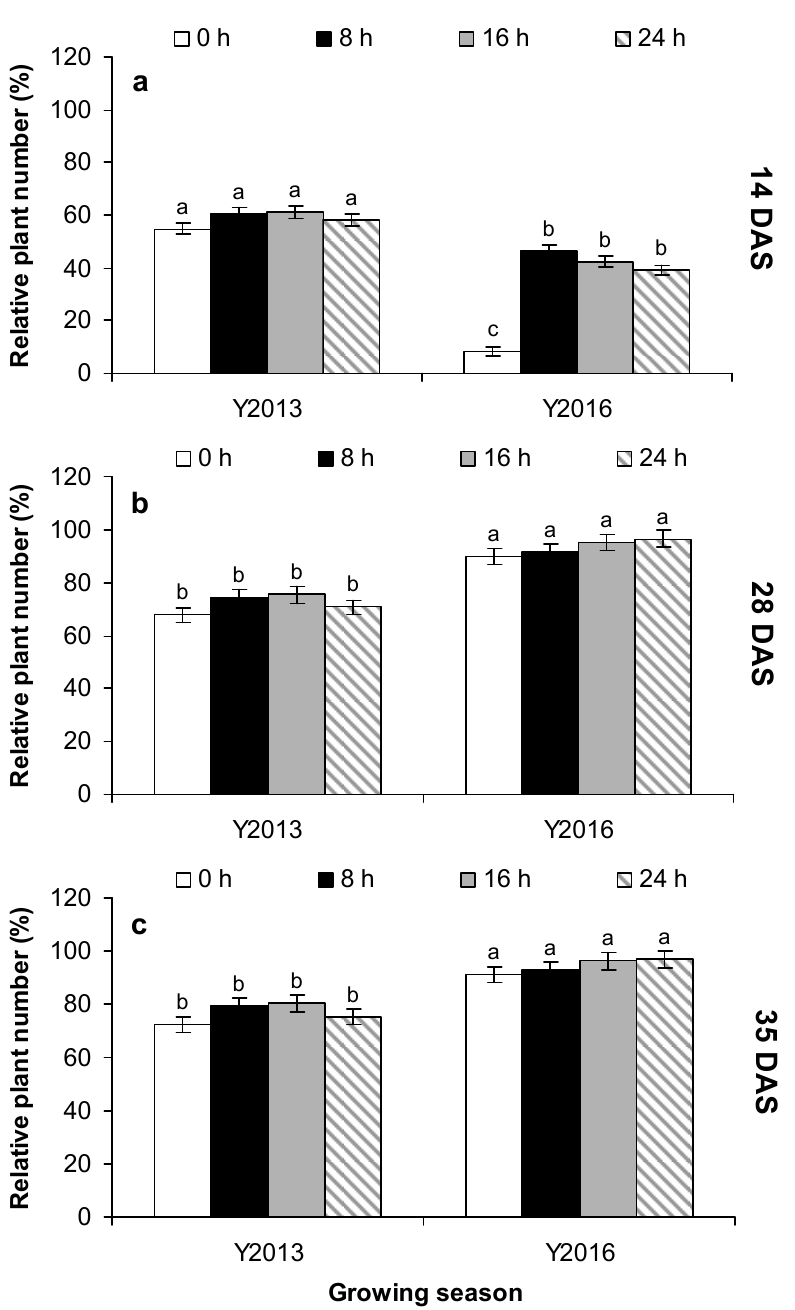
Figure 2. Plant number per m of row (%) at 14 ( a ), 28 ( b ), and 35 ( c ) days after sowing (DAS) (different letters show statistically significant differences according to least significant difference (LSD) test at p < 0.05; vertical lines denote standard errors of means).